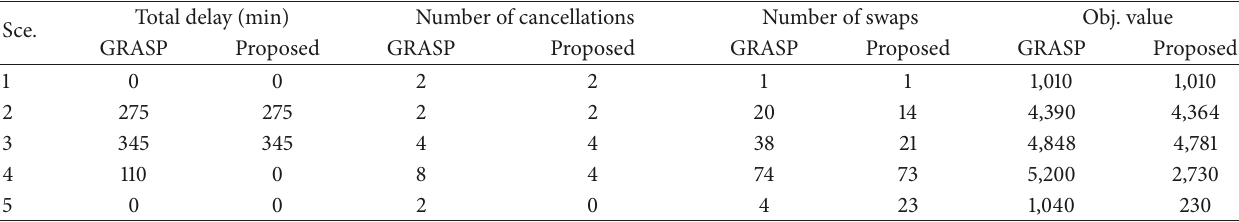
Table 6: Recovery solutions of the GRASP and the two-stage heuristic.